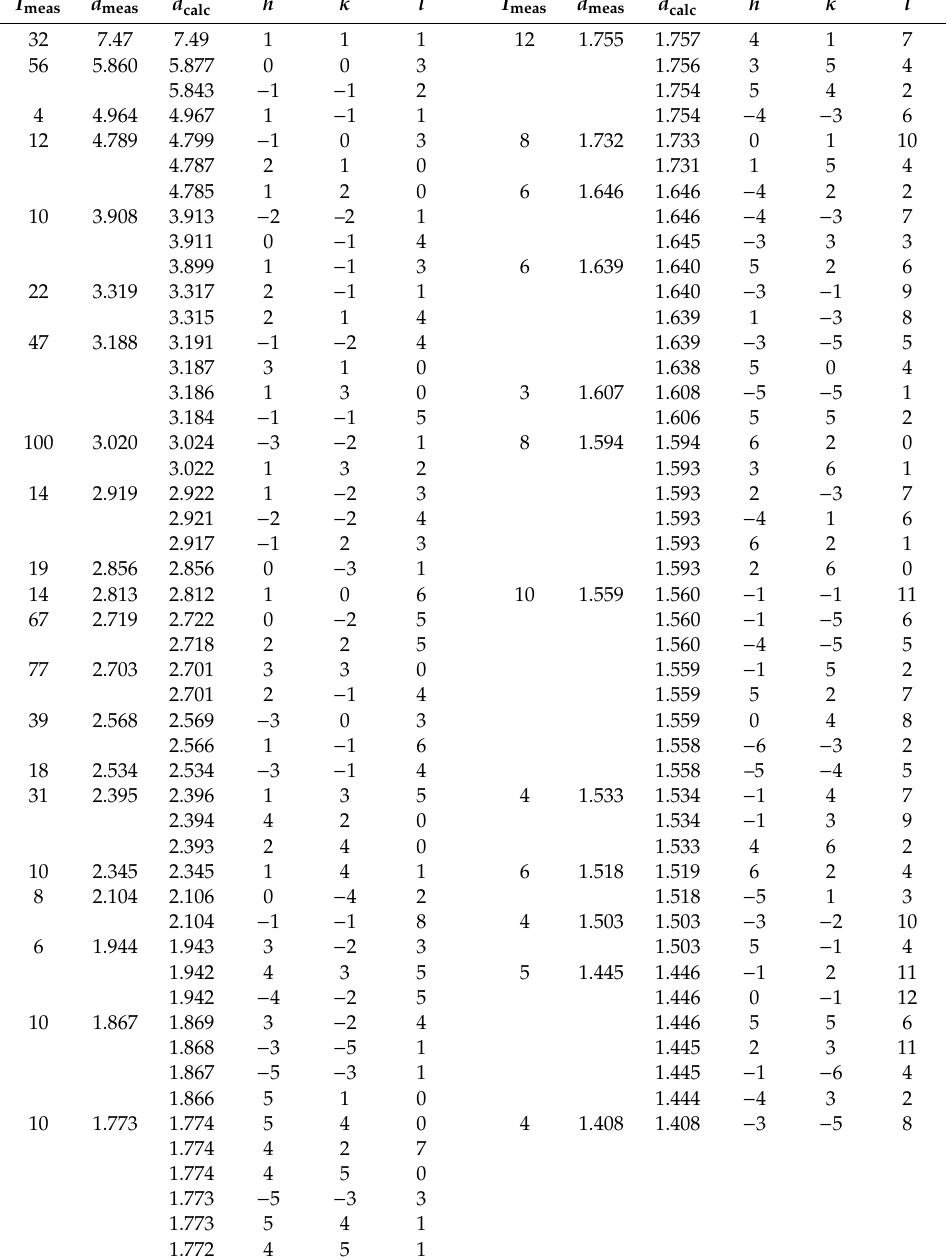
Table 3. Powder X-ray di ff raction data for xenophyllite (indexed in triclinic cell) ( d in